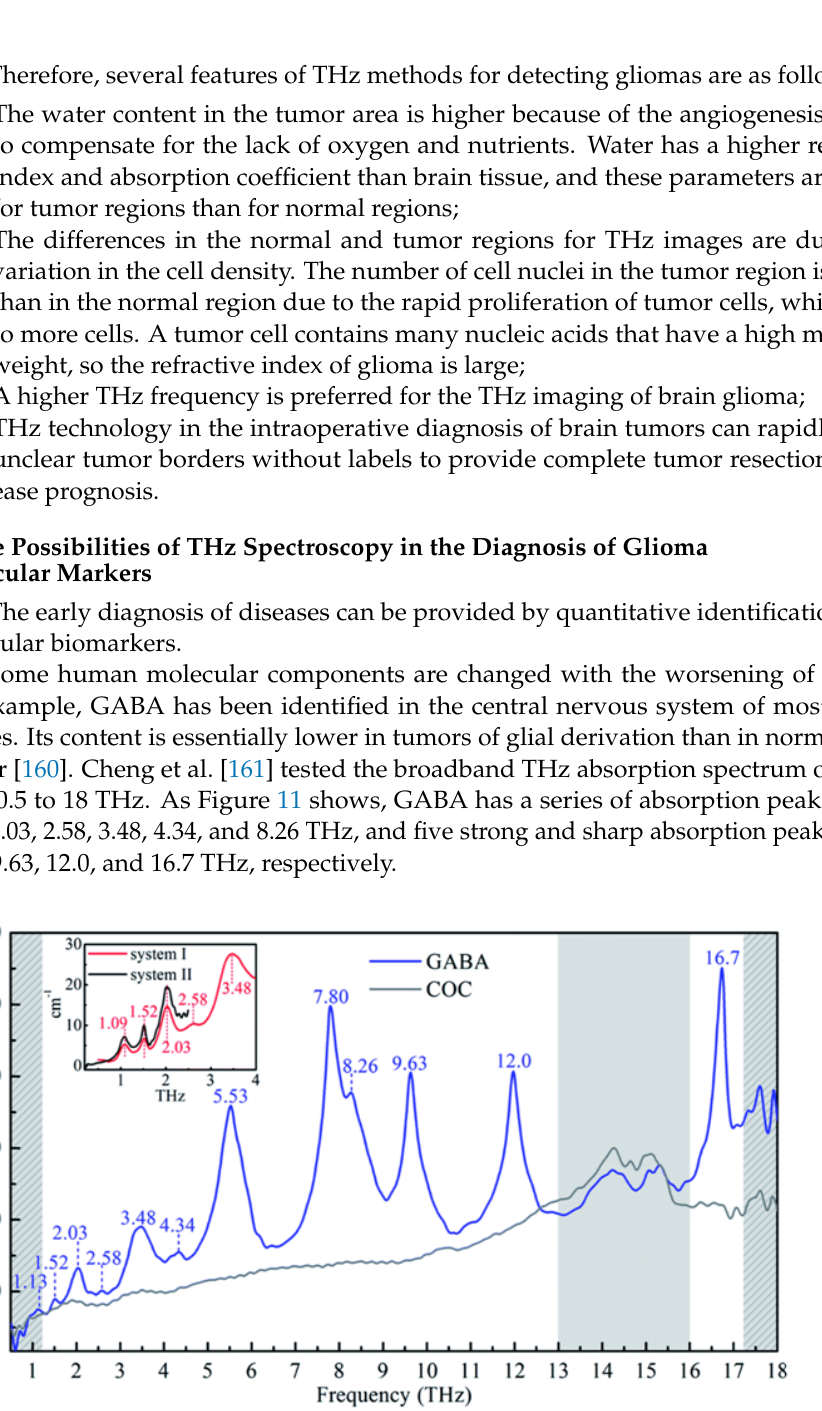
Figure 12. Molecular conformations of l-glutamic acid in α and β polymorphs, with the dihedral angles noted in the text indicated by curved arrows. Reprinted from [163].